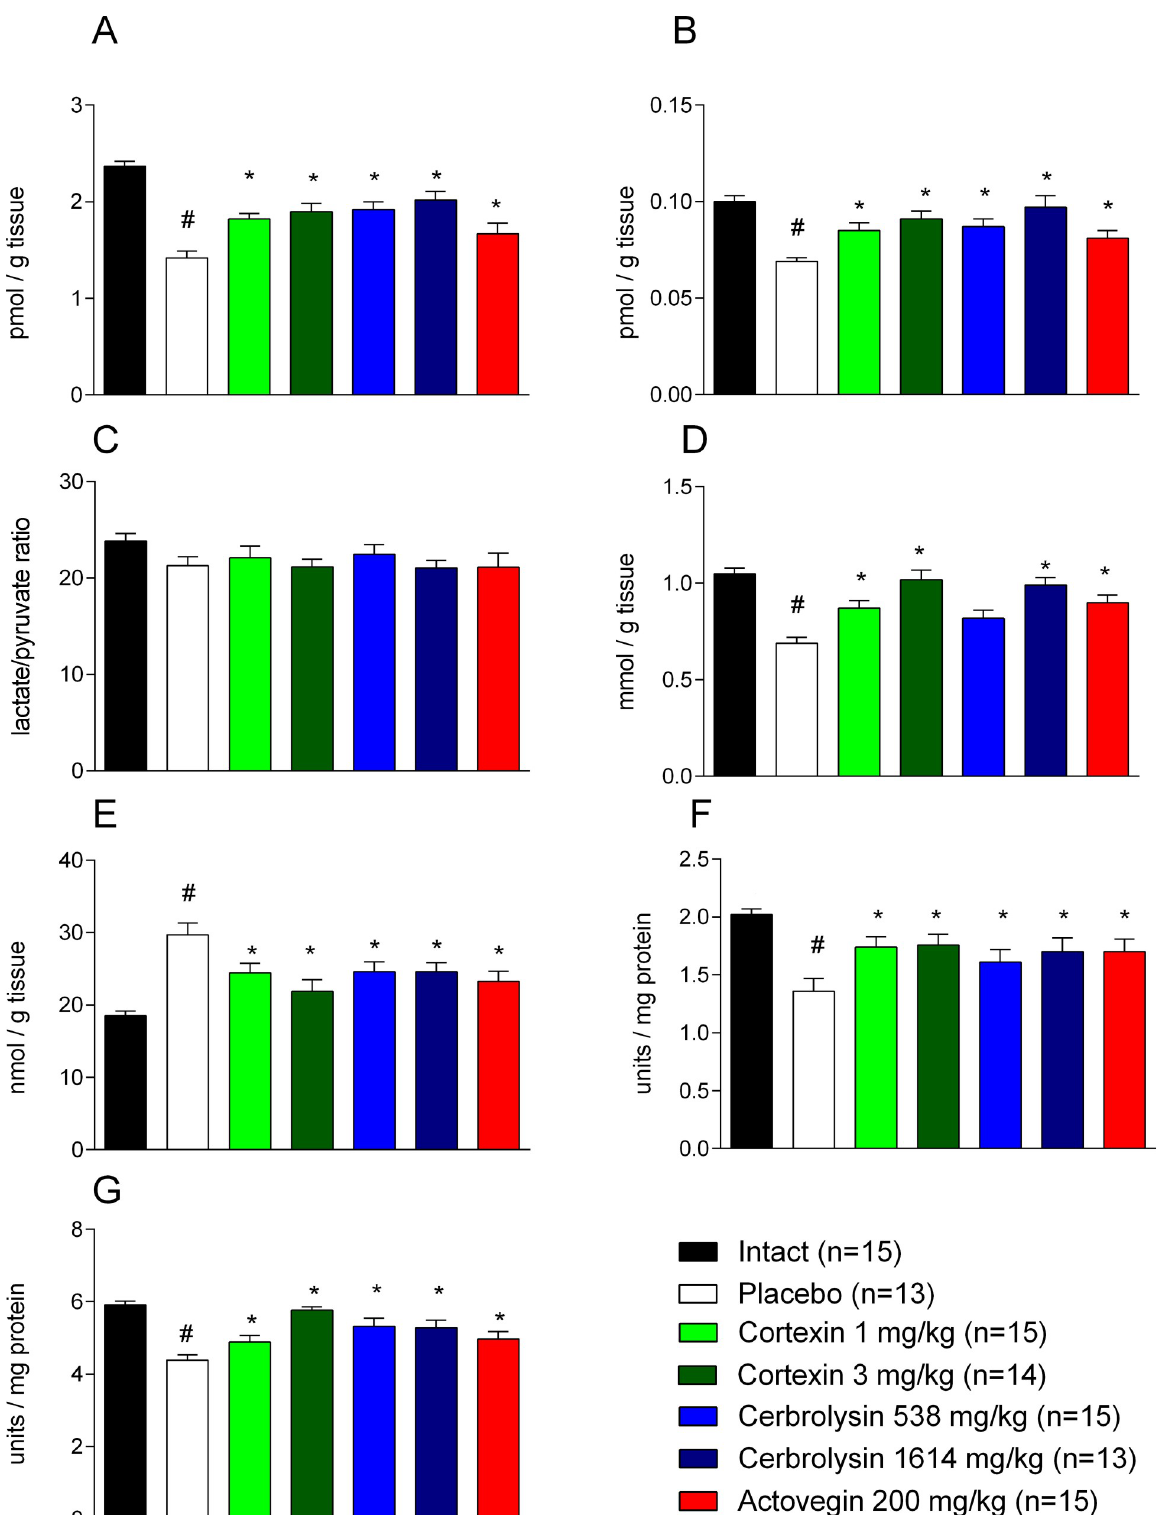
Fig 9. The activity of brain antioxidant systems in rats with chronic brain ischemia. (A) brain lactate levels; (B) brain pyruvate levels; (C) the relation of lactate to pyruvate in brain tissue; (D) brain glutathione levels; (E) malonic dialdehyde brain levels; (F) brain catalase activity; (G) brain